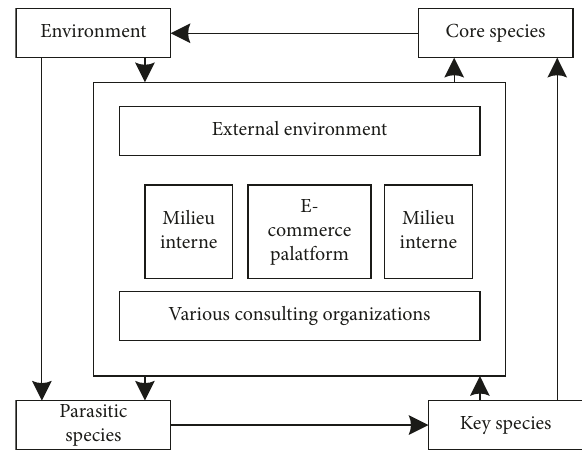
Figure 1: The e-commerce ecosystem structure diagram.